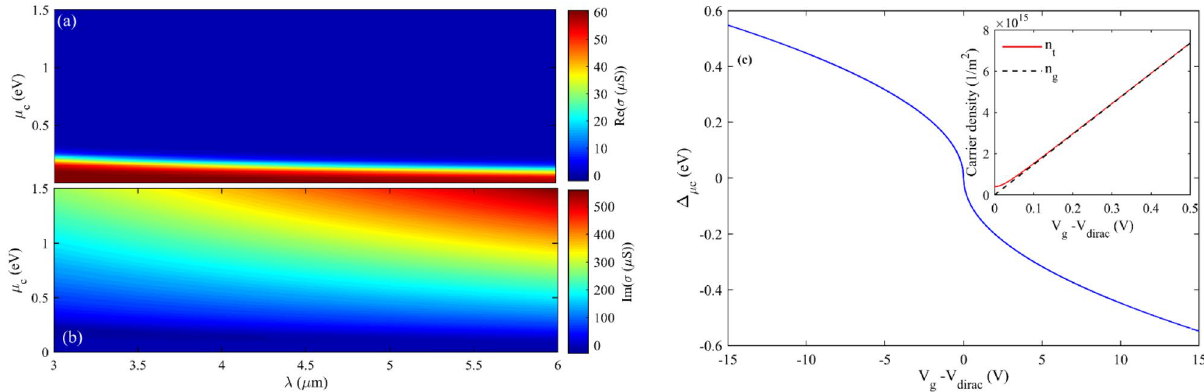
Figure 2. ( a ) Real and ( b ) imaginary parts of the surface conductivity of graphene versus wavelength and chemical potential (µ